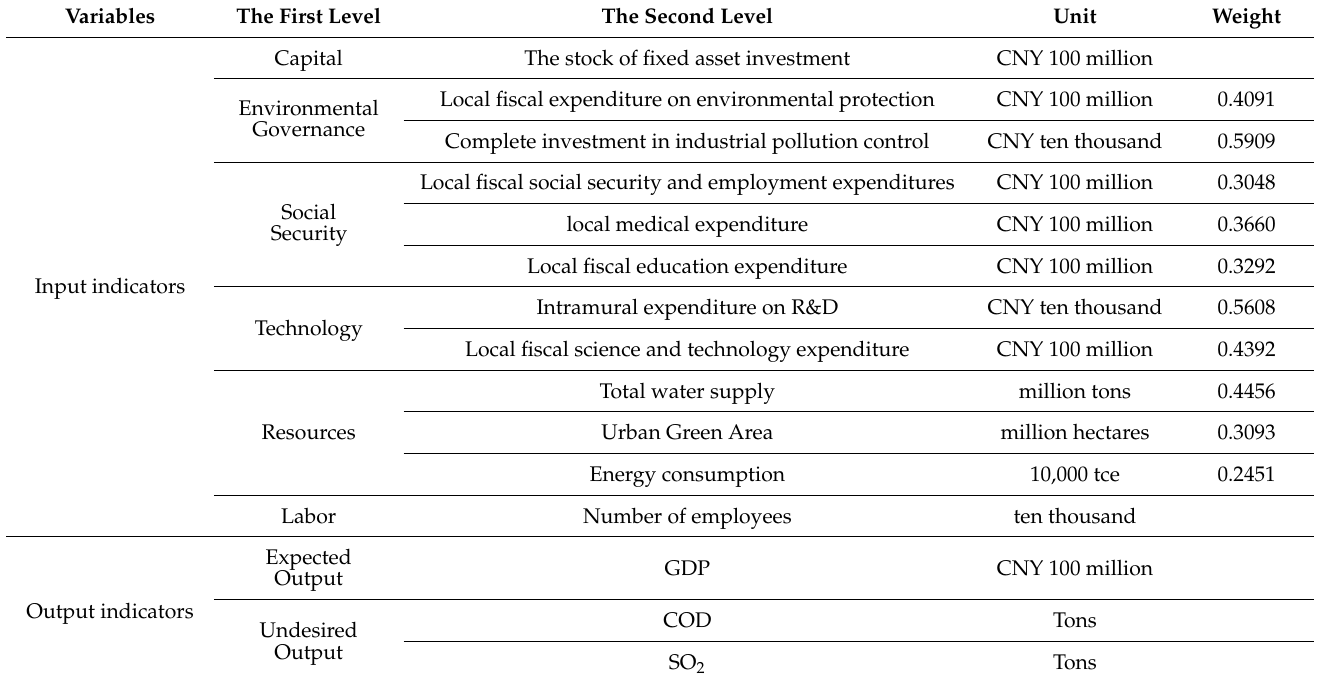
Table 1. Efficiency Index System of China’s Regional Economic Sustainable